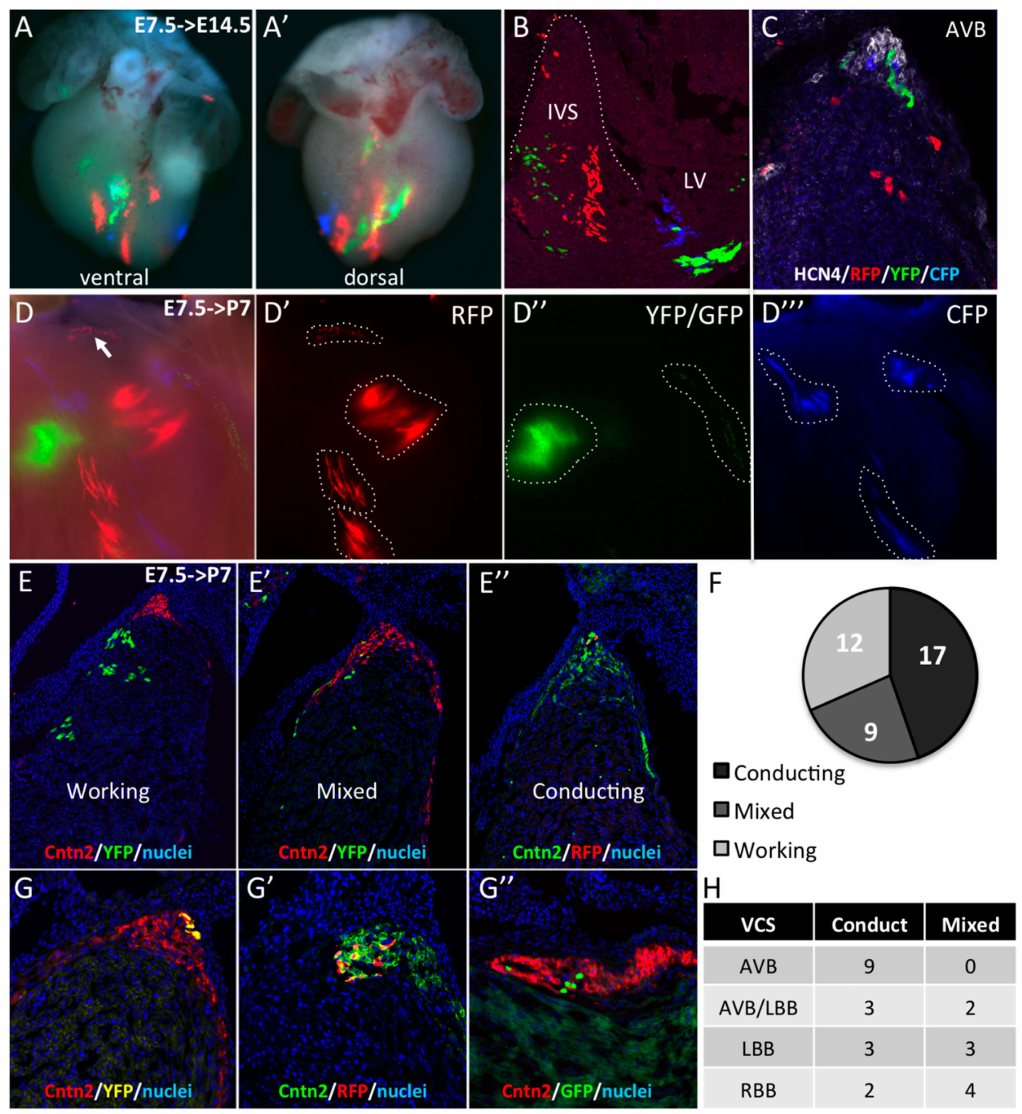
Figure 3. Early segregation of the central ventricular conduction system lineage in SMA+ cardiomyocytes. ( A , A’ ) Whole-mount ventral and dorsal views of an E14.5 Sma Cre {` ::R26R confetti {` heart with multicolor clusters induced by tamoxifen injection at E7.5. The four fluorescent reporters (GFP, YFP, RFP, and CFP) form independent clusters distributed side by side along the vertical axis in the apical interventricular region. ( B ) Section of an E14.5 Sma Cre {` ::R26R confetti {` embryonic heart showing large vertical compact multicolor clones in the apical region of the IVS and scattered labeled cells in the upper part of the septum. ( C ) Hcn4 immunofluorescence on section of E14.5 Sma Cre {` ::R26R confetti {` heart showing a heterogeneous contribution of labeled cells to the AVB and BB. ( D ) Example of clonal labeling in a P7 Sma Cre {` ::R26R confetti {` heart with a small number of labeled clusters of which one RFP+ cluster is localized at the crest of the septum (arrow). Individual fluorescent reporters are presented in D’ (RFP), D” (GFP/YFP) and D”’ (CFP). ( E , G ) Cntn2 immunofluorescence on sections from P7 Sma Cre {` ::R26R confetti {` hearts to classify the nature these clusters. All cells in working clusters are negative for Cntn2 ( E ), few are positive in mixed clusters ( E’ ) and all are positive for Cntn2 in conducting clusters ( E” ). The distribution of these clusters is presented in the graph in the right panel ( F ). ( G , G’ , G” ) Sections through independent conducting clones of different colors (YFP in G ; RFP in G’ or GFP in G” ) showing co-labeling with Cntn2 in the AVB. ( H ) Table showing the distribution of mixed and conducting clones in different compartments of the central